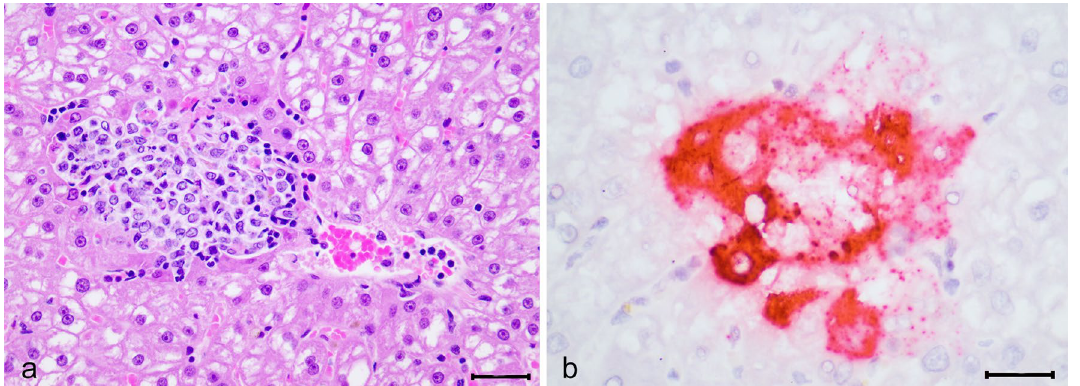
Figure 5. Histological lesions and localization of Kasokero virus (KASV) nucleoprotein RNA by in situ hybridization in a KASV-inoculated bat (044,997) euthanized at 3 days post inoculation. ( a ) A peri-venular aggregate of mononuclear inflammatory cells focally disrupts the hepatic parenchyma. Numerous degenerating hepatocytes are present along the periphery and mixed with the inflammatory cells. Hematoxylin and eosin stain, 40 ×, scale bar 20 µM. ( b ) Extensive positive hybridization signal for the KASV nucleoprotein gene is present in the cytoplasm of hepatocytes surrounding and within a focus of inflammation. Red chromogen with hematoxylin counterstain, 60 ×, scale bar 20